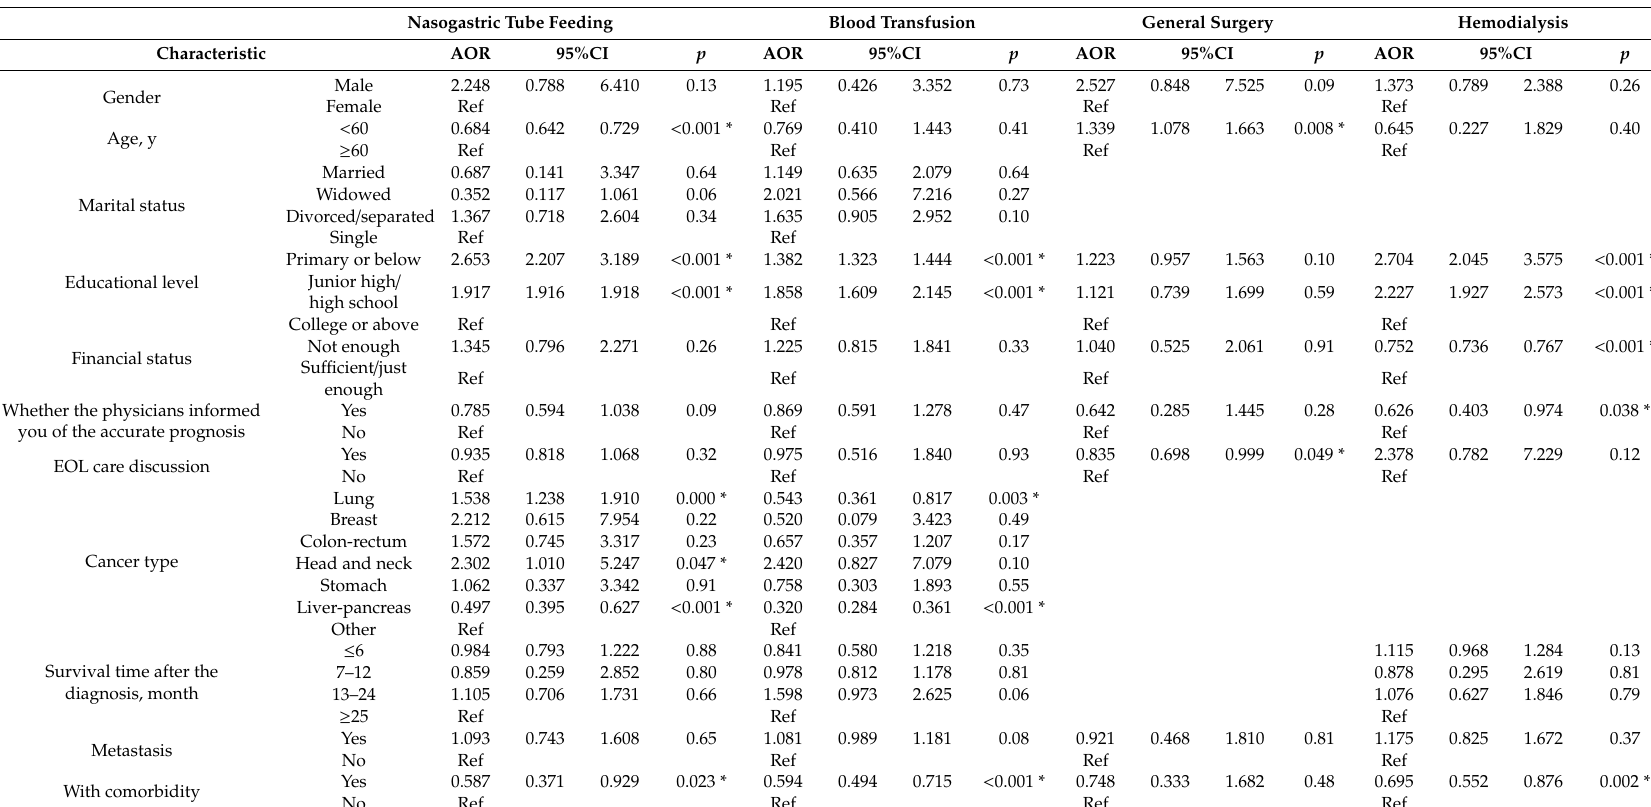
Table 3. Factors associated with Preferences for aggressive End of Life (EOL) Care: Nasogastric Tube Feeding, Blood Transfusion, General Surgery, and Hemodialysis. Nasogastric Tube Feeding Blood Transfusion General